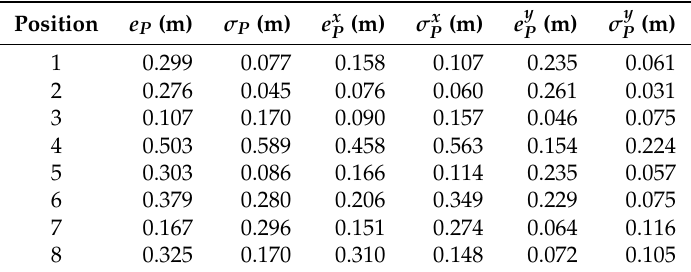
Table 10. Measured accuracy of the PSO algorithm in Scenario